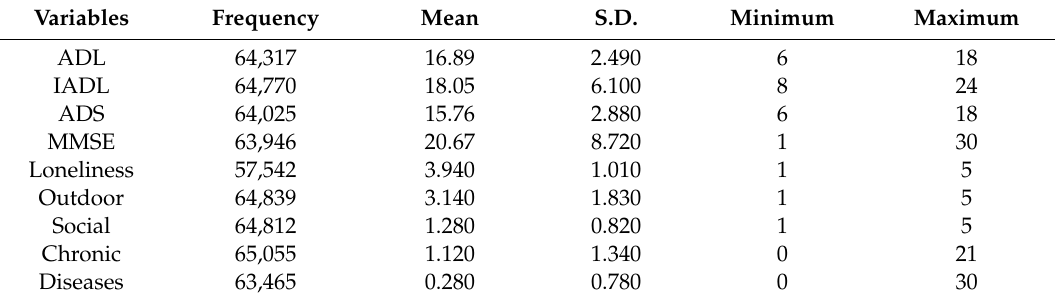
Table 2. Descriptive statistics of indicator variables (five periods pooled